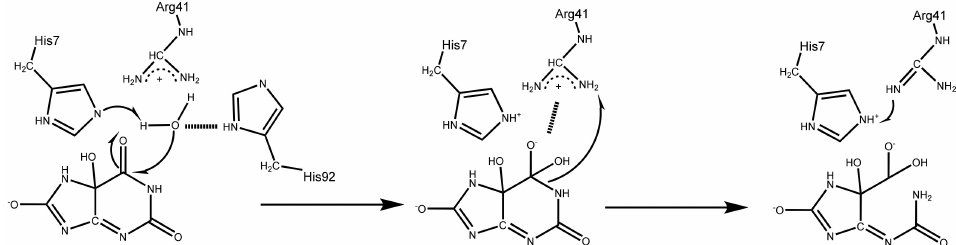
Scheme 2. A mechanistic proposal by French et.al for the conversion of 5-hydroxyisourate to 2-oxo-4-hydroxy-4-carboxy-5- ureidoimidazoline by kp